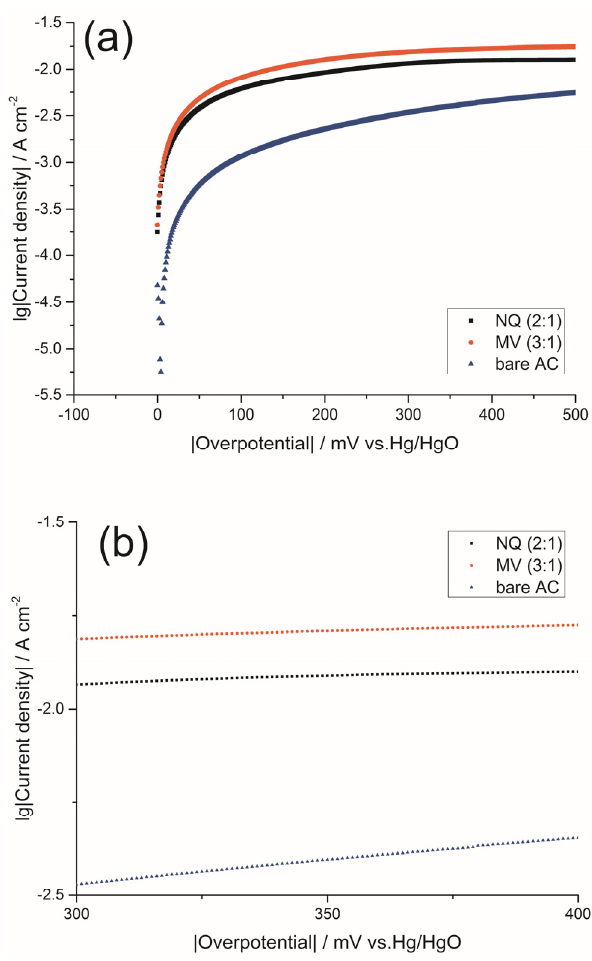
Figure 5. Tafel plots of different anodes ( a ) and enlarged scale graph for the Tafel plots of overpotential from 300 mV to 400 mV ( b ). Table 3. Exchange current density calculated from the Tafel plots.